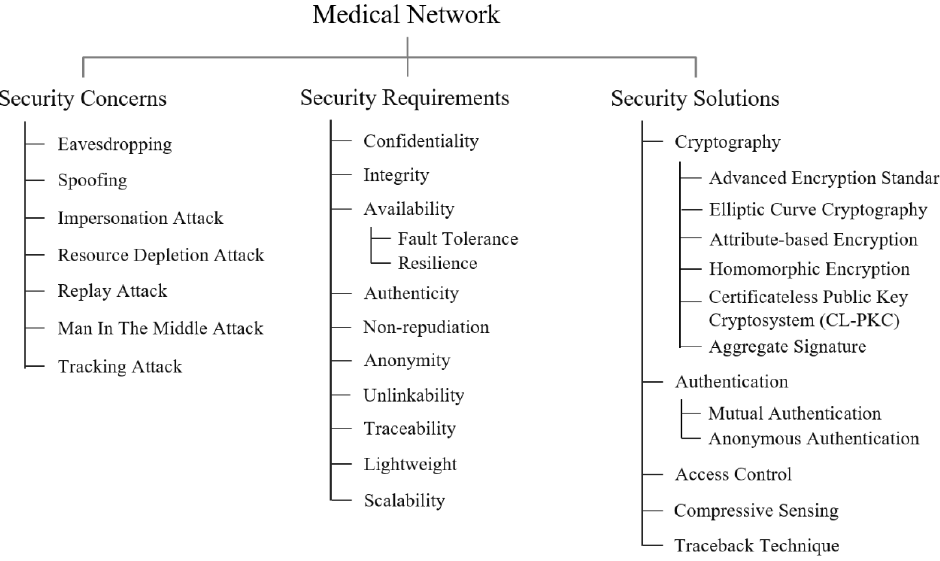
Figure 5. Taxonomy for security and privacy on medical